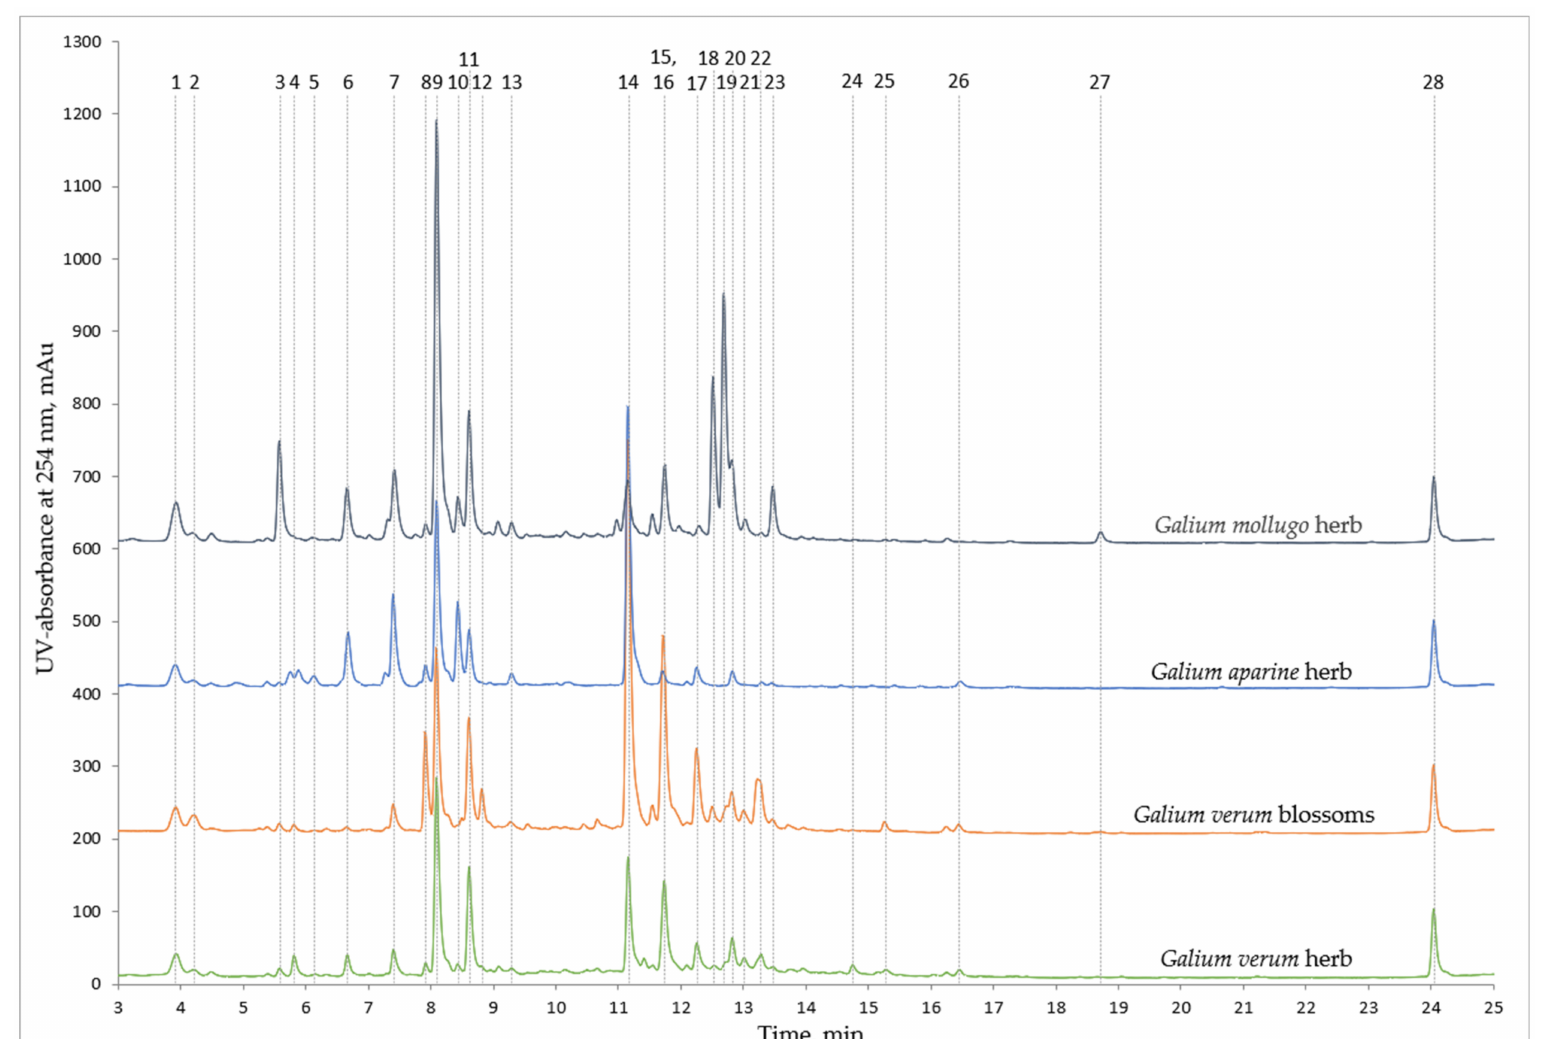
Figure 1. All quantified phytochemicals on chromatograms of 50% ethanol extracts of analysed Galium